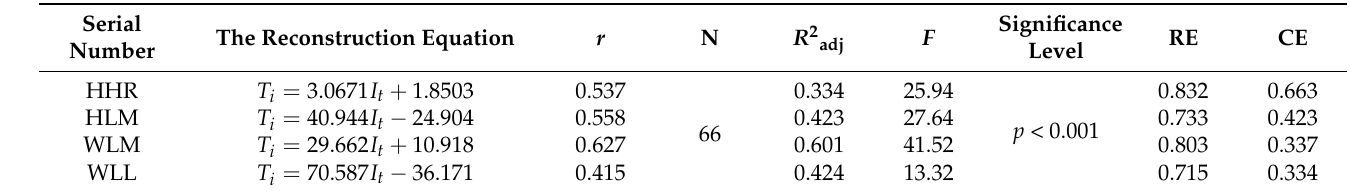
Table 3. Functions and associated parameters for reconstructing growth-season precipitation in different areas.